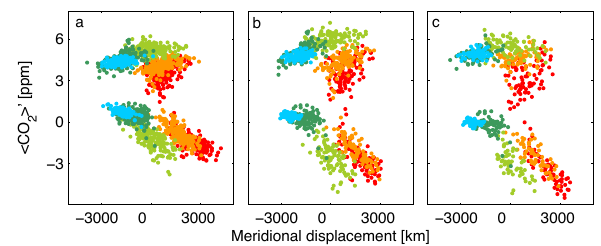
Fig. 15. Northern Hemisphere TCCON h CO 2 i 0 plotted against meridional displacement (relative to Park Falls) for three simula- tions with perturbed surface fluxes. In each panel, the top cloud of points shows May data while the lower cloud of points shows Au- gust data. (a) CASA fluxes. (b) Boreal fluxes enhanced. (c) Boreal fluxes enhanced with early onset of the growing